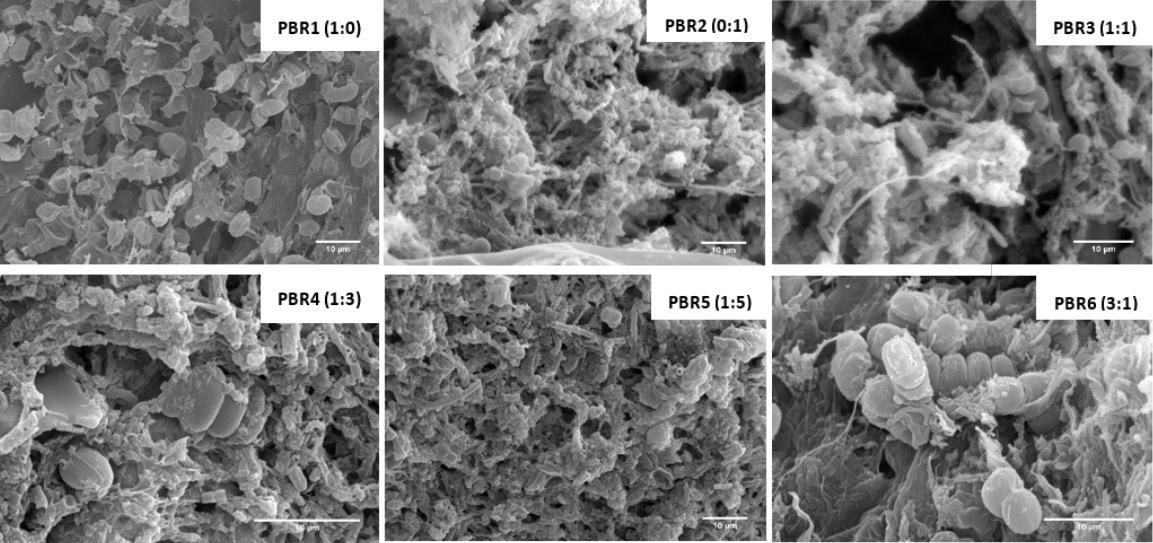
Figure 7. The structuring process of the photogranules in photobioreactors .